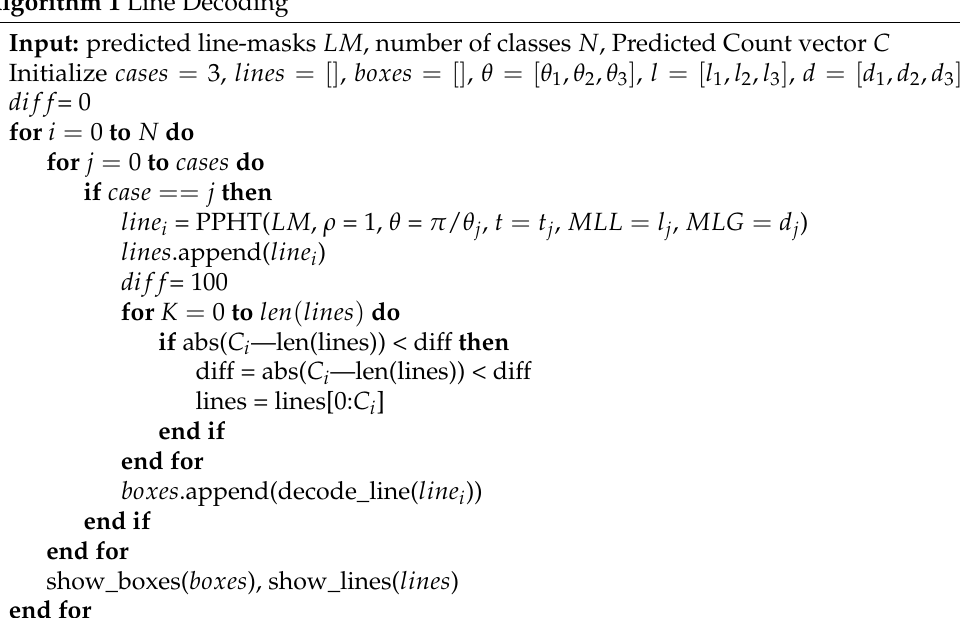
Algorithm 1 Line